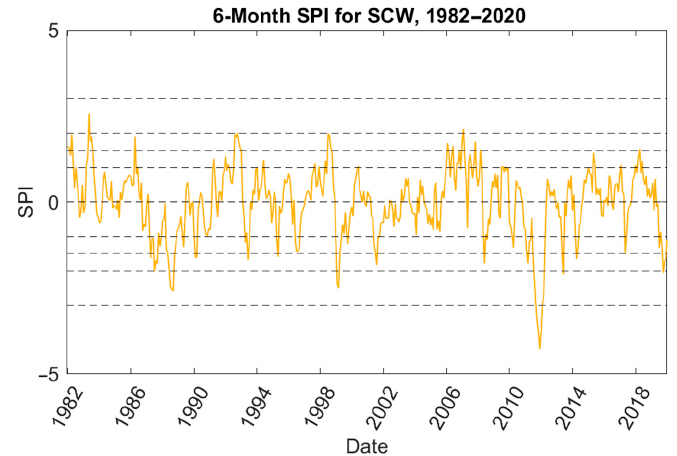
Figure A6. 3 ‐ Month SPI from 1982 to 2020.